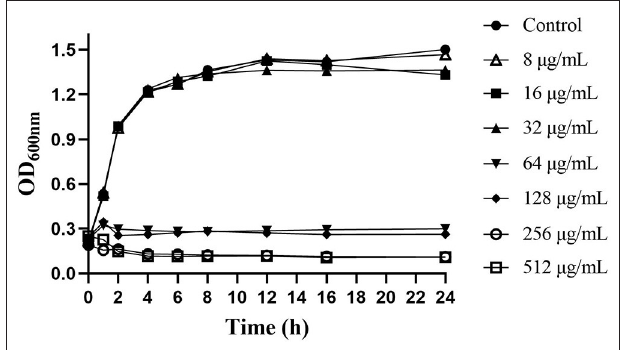
FIGURE 1 | Effects of different concentrations of thymol on the growth of S. iniae strain HT in BHI broth.